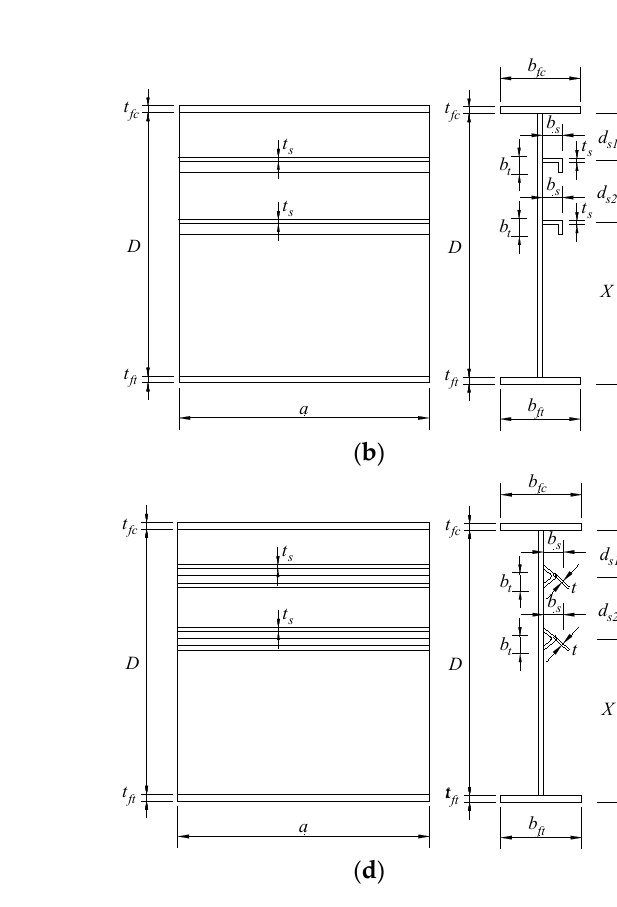
Figure 2. Geometric dimensions of stiffened plate girders with various stiffener cross-section shapes. ( a ) T-shaped; ( b ) L-shaped; ( c ) Rectangular-shaped; ( d ) Triangular-shaped.